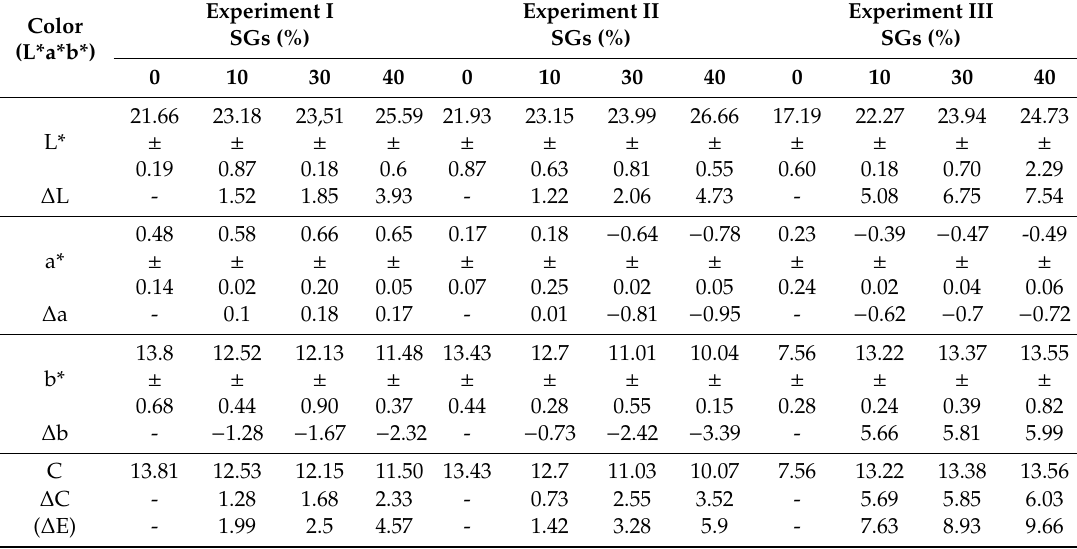
Table 4. Color comparison of apple preserves with various SGs’ level addition ( x ± SD )